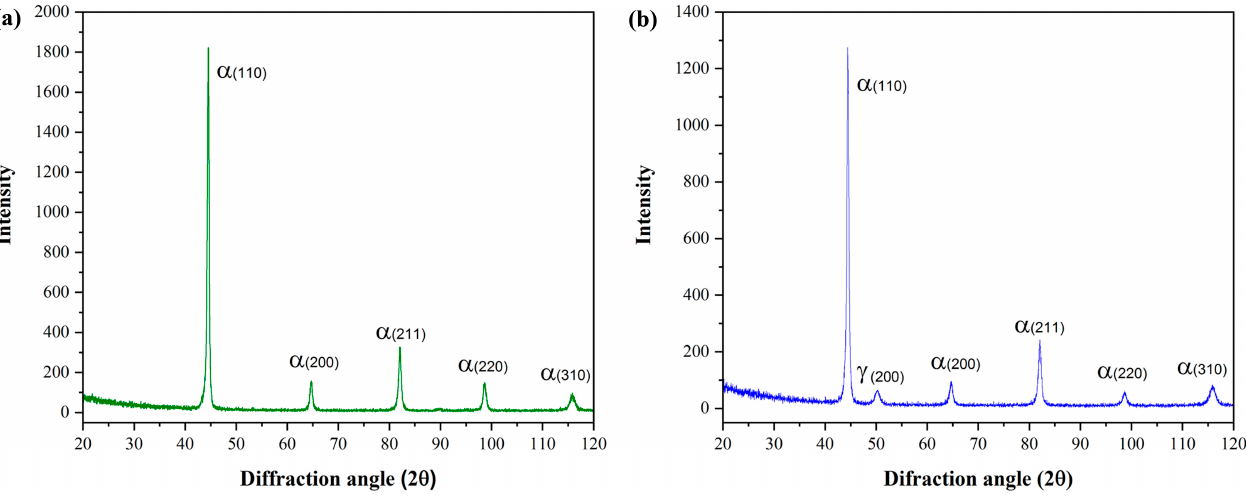
Figure 4. X-ray diffraction patterns of CP steels in the as-cast condition: ( a ) boron-free (CP-B0) steel, and ( b ) boron-containing (CP-B60) steel.